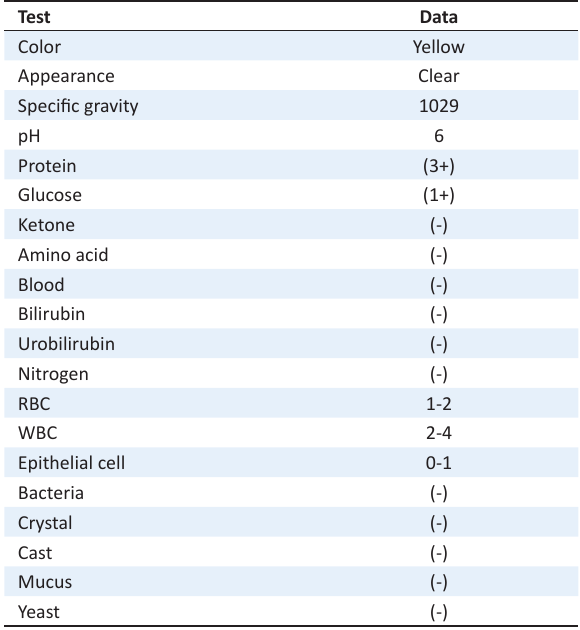
Table 3. Urinalysis of the patient with multiple myeloma and acute renal